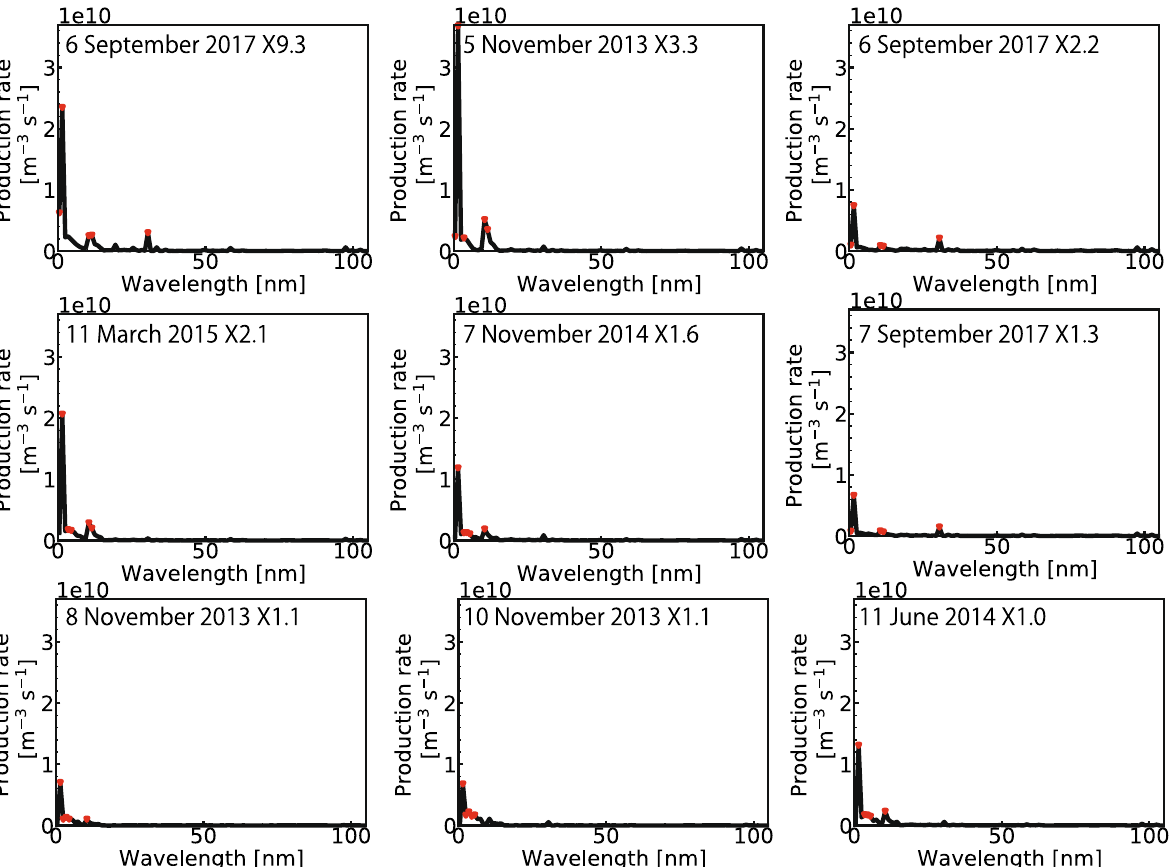
Fig. 9 Relationship between the solar emission and the difference in ion production rate. The relationship between the solar emission and the difference in ion production rate between pre-flare and DTEC peak time calculated by GAIA with RUN-FS15. The difference in ion production rate is the difference between the pre-flare and the DTEC peak time, integrated over height. Data from points where the local time was around noon at the time of each flare event are used. The red triangles in each panel indicate the top five wavelengths at which the ion production rate was the